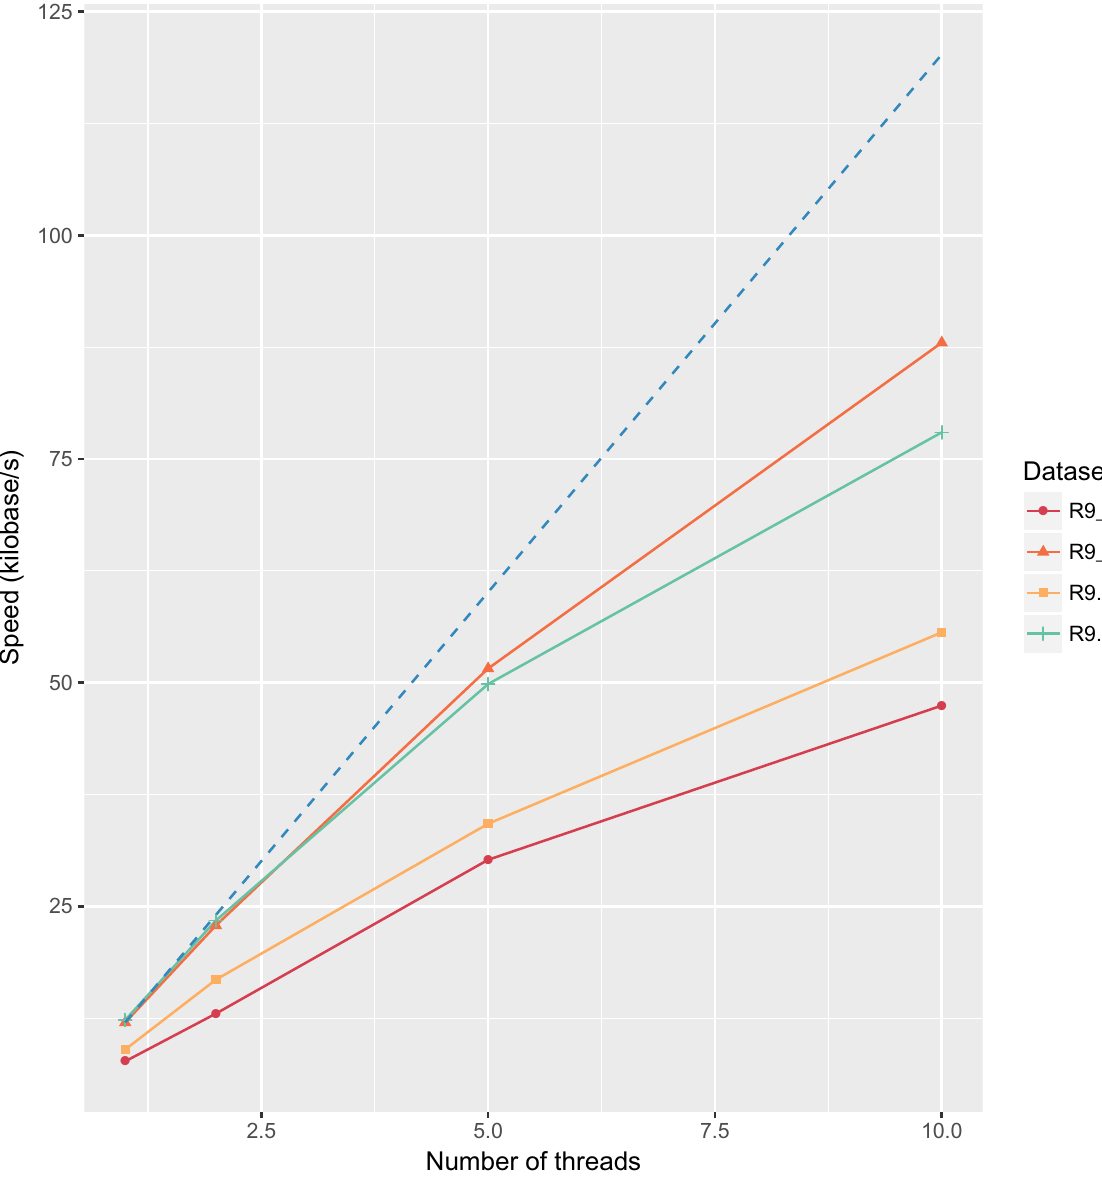
involve real-time compression for laptop disk space concerns, reduction of bandwidth usage for transfer of datasets between laboratories, or reduction of the storage footprint on shared data